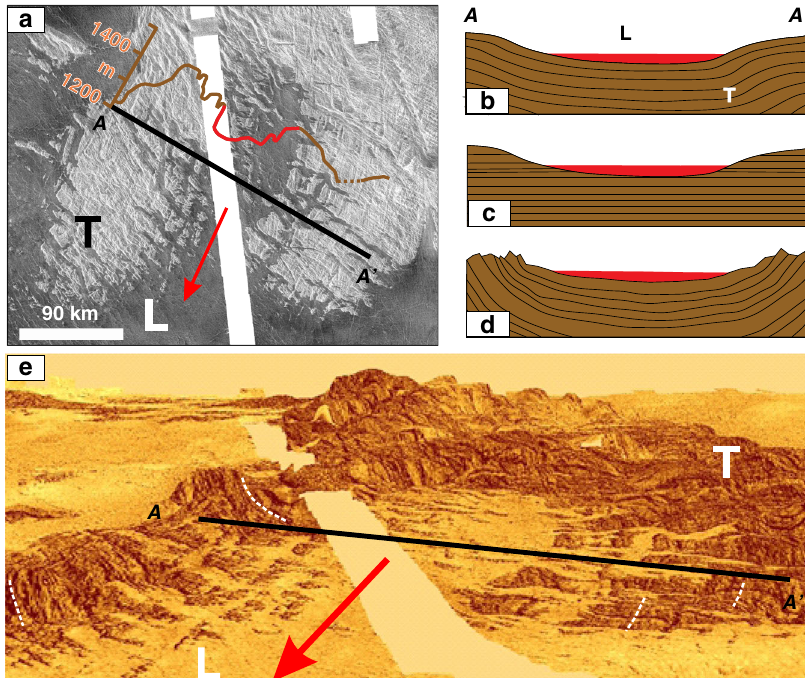
Fig. 1 Evidence for erosion in the southern portion of Salus tessera. a Left-looking Cycle 1 Magellan SAR image (central coordinates 4.4°S, 48.2°E); north is up, showing tessera (light grey and lineated) with a re-entrant area that has been fl ooded by younger plains lavas (featureless dark grey). White band marks absence of Magellan SAR data, but topographic data are available in this region. The topographic relief between the valley (covered by lava fl ows) and bordering tesserae hills is about 100 m (along pro fi le line A – A ’ ). Dotted portion of brown line extrapolates across a topographic data artefact (appearing as a topographic ‘ hole ’ ) in the dataset. Red portion of topographic pro fi le corresponds to the portion fl ooded and embayed by plains lavas. Edge of main fl ooding (red line) on left side extrapolated from the SAR image on both sides of the data gap. b – d End-member generalized alternative geological interpretations for cross-section A – A ’ of which only the third ( d ) fi ts the observations: b a purely tectonic interpretation whereby these landforms are a central syncline and bordering anticlines; c a purely fl uvial erosional interpretation, or d initial tectonic activity (synclinal folding) followed by fl uvial erosion. T = tesserae and L = younger ma fi c lava fl ows. e Elevated oblique view (looking north) generated by draping the SAR image onto Magellan altimetry topography using the software ArcScene. Vertical exaggeration is 20× and the viewing elevation angle is about 20°. The tessera is orange and the younger ma fi c lava fl ows are light yellow, and the smooth yellowish-white band is the missing data. Noteworthy are the white dashed lines in e that correspond to prominent lineament sets that may re fl ect inward dipping strata on both fl anks of the inferred